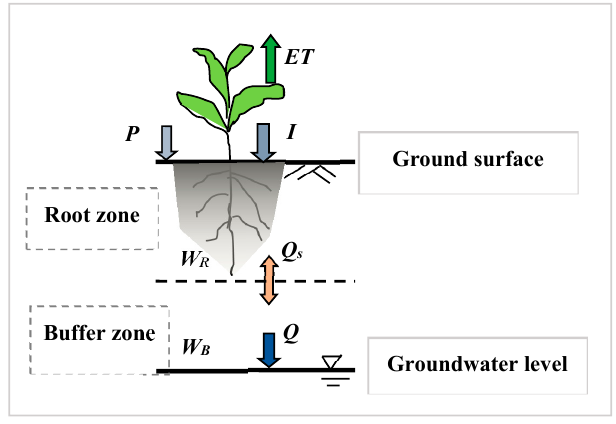
Figure 3. Water balance in vadose zone of farmland.